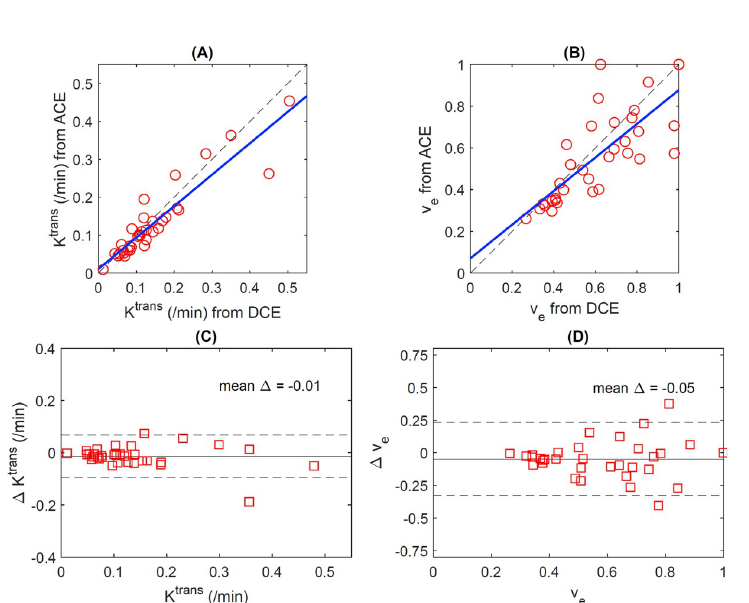
Fig 4. Scatter plots showed the tumor median values comparisons (red circle) between DCE-MRI and ACE-MRI methods for K trans (a) and v e (b) for all the tumors of the 17 mice. Blue lines are regression lines and dash lines are lines of unity. The correlation coefficients are 0.92 for (a) and 0.78 for (b) with p -values < 0.0001 for both cases. Bland- Altman plots show tumor median value comparisons (red square) between DCE-MRI and ACE-MRI methods for pre and post-treatment for all tumors of the 17 mice: K trans pre/post-treatment (c) and v lines are the mean difference (actual values are noted in each plot) and dash thin lines are mean Δ ± 1.96 SD.